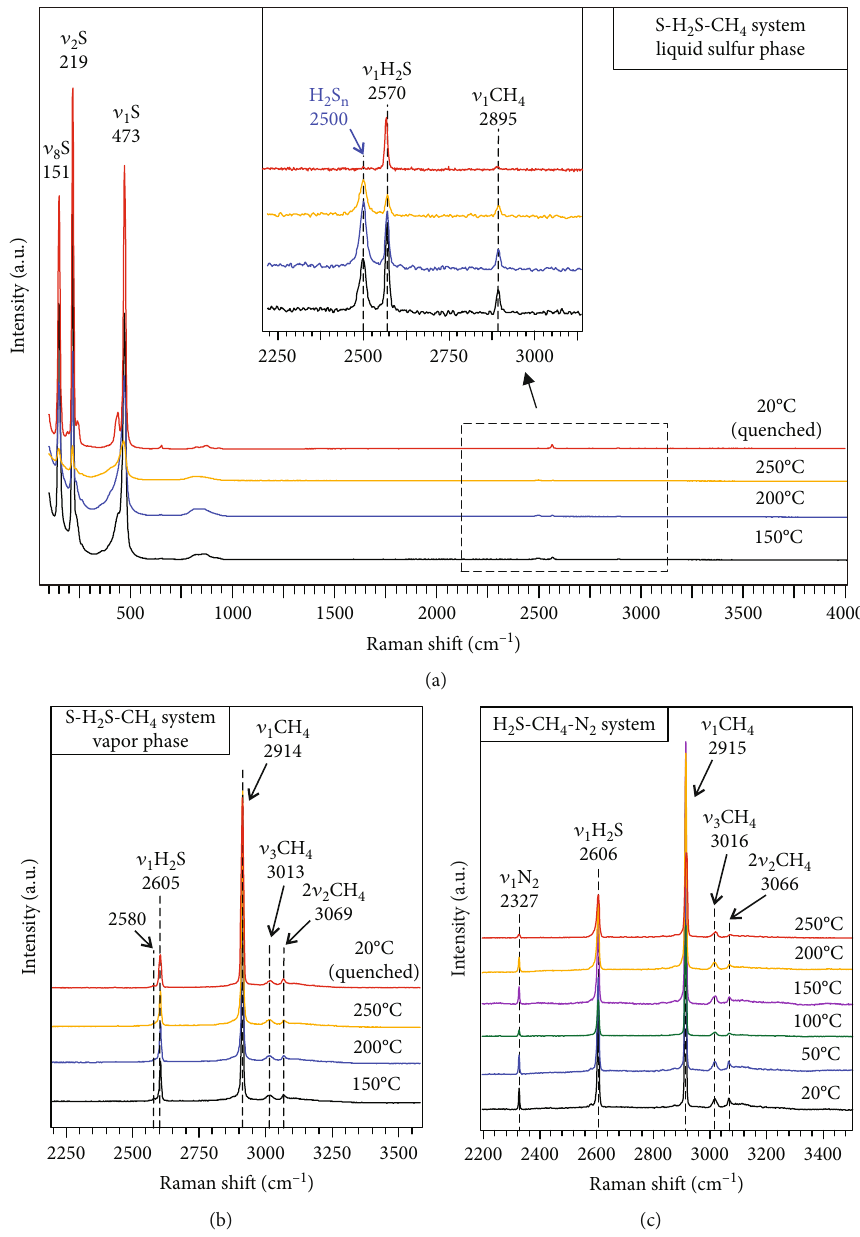
Figure 4: In situ Raman spectra of the S – H – N H S – CH system at 20 – 250 ° C ((c) vapor 2 4 2